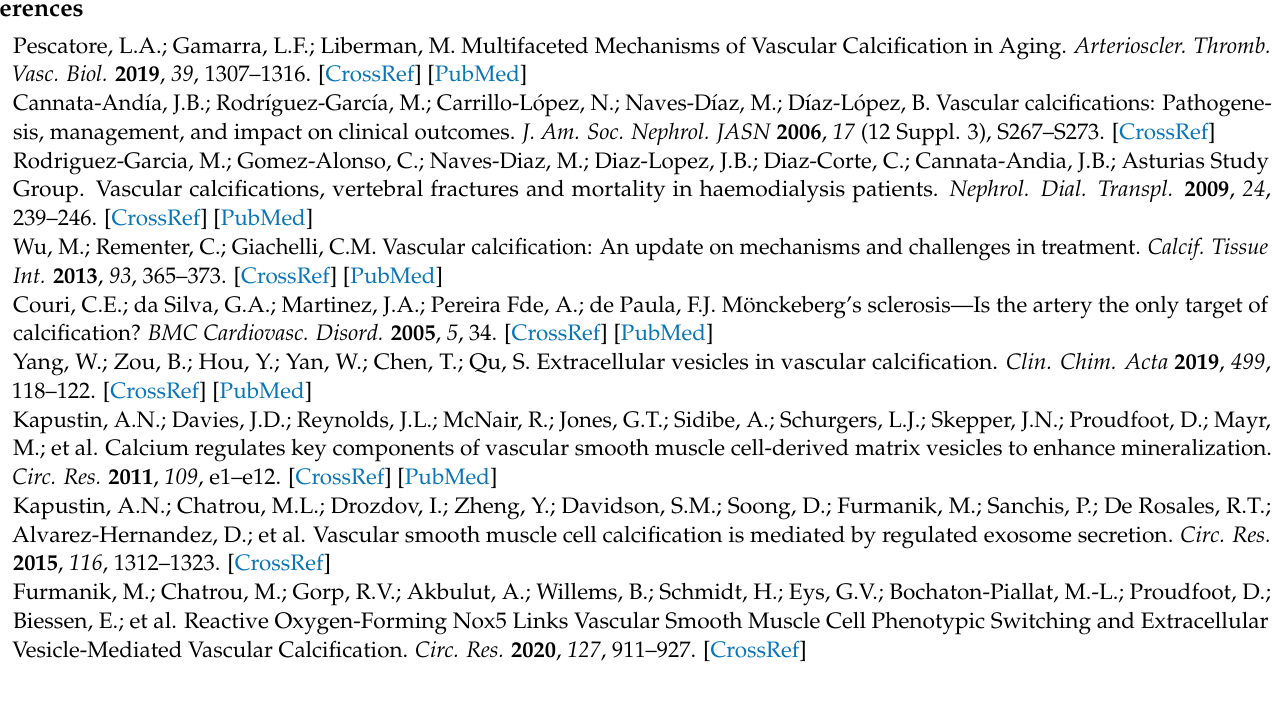
Graphical presentation of compound clustering in DataWarrior. Figure S3B Graphical presenta- tion for cluster 8 in DataWarrior. Figure S3C Graphical presentation for cluster 103 in DataWarrior. Figure S4A 3D docking pose of compound 5728450 after redocking. Figure S4B 3D docking pose of compound 5122895 after redocking. Figure S4C 3D docking pose of compound 5274372 after redocking. Figure S4D 3D docking pose of compound 5150856 after redocking. Figure S4E 3D docking pose of compound 4011505 after redocking. Figure S4F 3D docking pose of compound 5402122 after redocking. Figure S4G 3D docking pose of compound 5784643 after redocking. Figure S4H 3D docking pose of compound 6924649 after